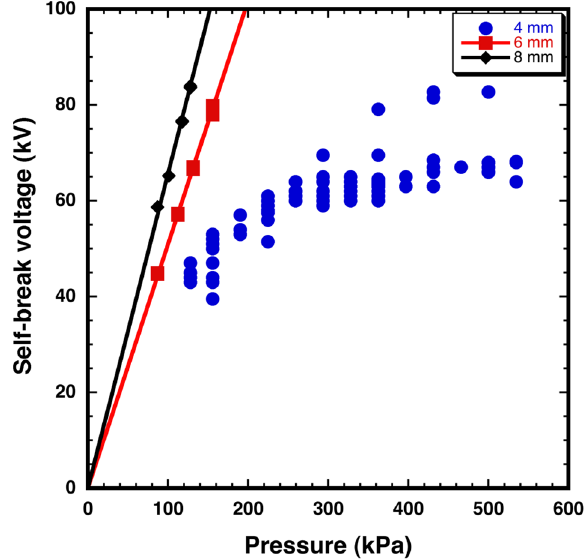
FIG. 3. (Color) Self-breakdown voltage versus pressure in pure SF 6 for 4, 6, and 8 mm gaps. The variations in self-breakdown voltage are more pronounced at higher pressure. The slope ratio of the two fitted lines (6 and 8 mm) is 1.29; the ratio of the gaps is 1.33, indicating reasonably linear SF 6 insulating behavior at those pressures and